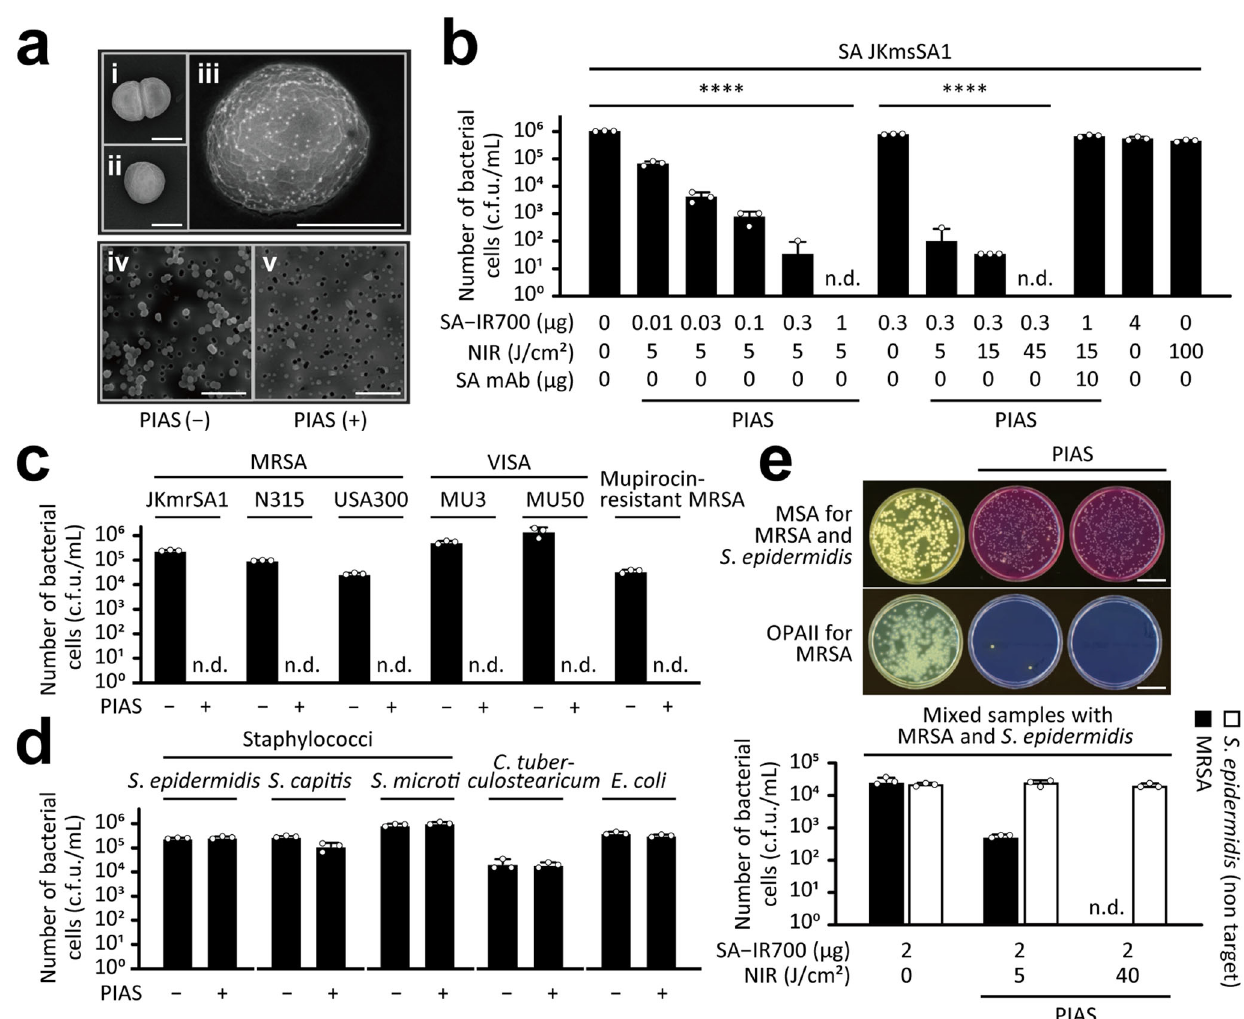
Fig. 2 Bactericidal effect of PIAS. a Scanning electron microscopic (SEM) analysis of Staphylococcus aureus (SA) cells treated with SA – IR700 conjugate after immunogold staining (i – iii). Untreated (i) and colloidal gold IgG-treated cells (ii). (iii) Bright dots indicate the presence of conjugates. SEM analysis of untreated (iv) and PIAS-treated (v) SA cells. Scale bars indicate 0.5 µ m (i – iii) and 5 µ m (iv and v). b , c Bactericidal effect of PIAS on b SA and c drug- resistant SA strains. d Effect of PIAS on non-target bacteria. SA – IR700, 1 μ g/test; near-infra-red light (NIR) illumination, 30 J/cm 2 . SA – IR700 was used in both PIAS ( − ) and ( + ) groups. e Target-selective bactericidal effect of PIAS. MRSA and Staphylococcus epidermidis formed yellow and pink colonies, respectively. Scale bars indicate 3 cm in ( e ). MSA mannitol salt agar with egg yolk, OPAII OPAII Staphylococcus agar, c.f.u. colony-forming units, n.d. not detected, n.s. not signi fi cant ( p > 0.05). Mean and s.d. values are shown from triplicate samples; data and images are representative of at least three independent experiments. For statistical analyses, ANOVA ( b ) and ANOVA with the Sidak test ( e ) were performed. **** p <